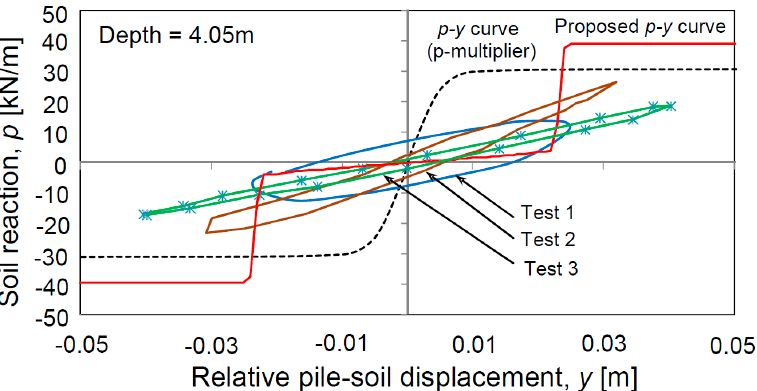
Figure 44. Comparison between p–y curves back-calculated from centrifuge tests and p–y curves constructed according to the proposed method and the p-multiplier approach for various